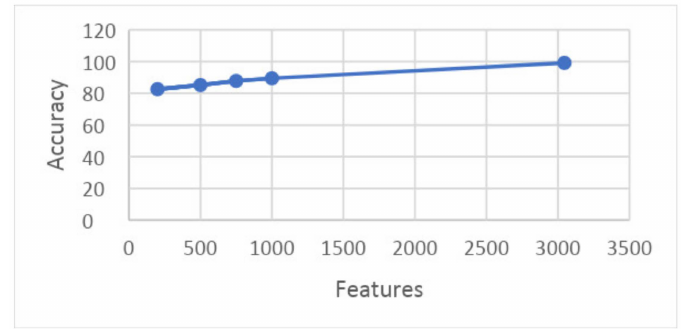
Figure 23. Graph showing features and accuracy on 10